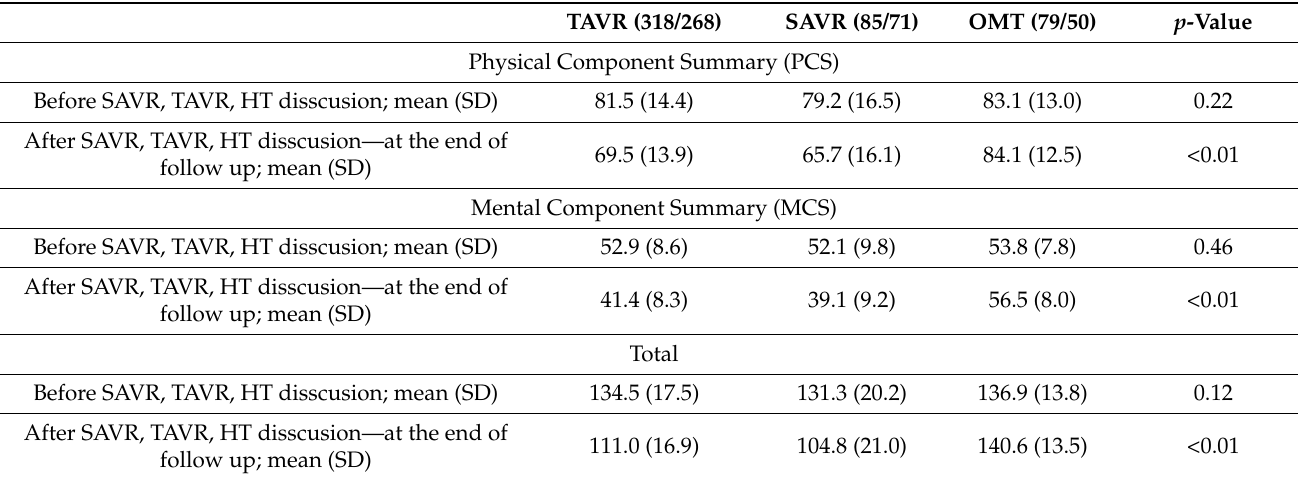
Table 4. The quality of life before and after Heart Team (HT) decisions